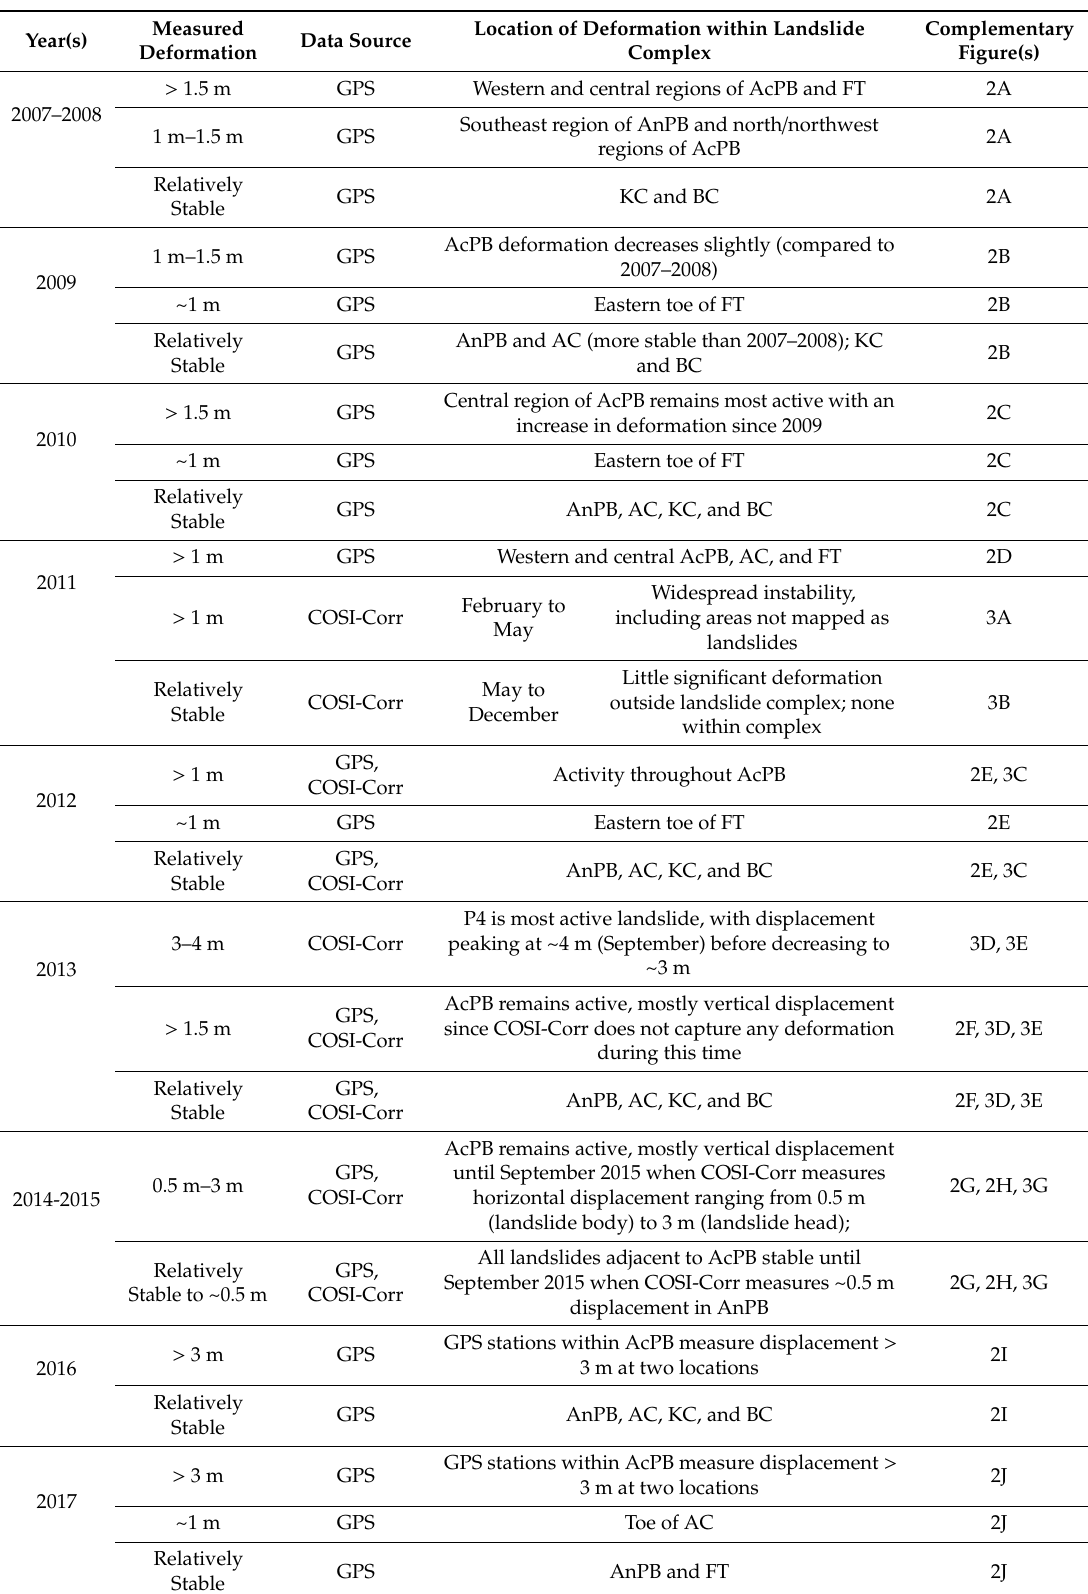
Table 3. Descriptive history of the Portuguese Bend landslide complex (2007–2017). Location of Deformation within Landslide Year(s)